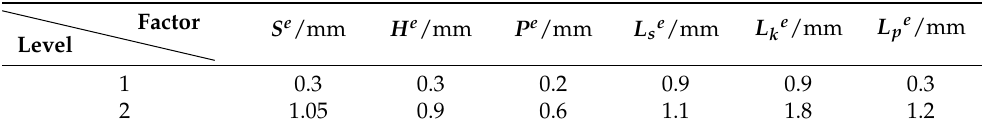
Table 6. Optimal levels of electromechanical coupling identification parameters for flexible interconnection.